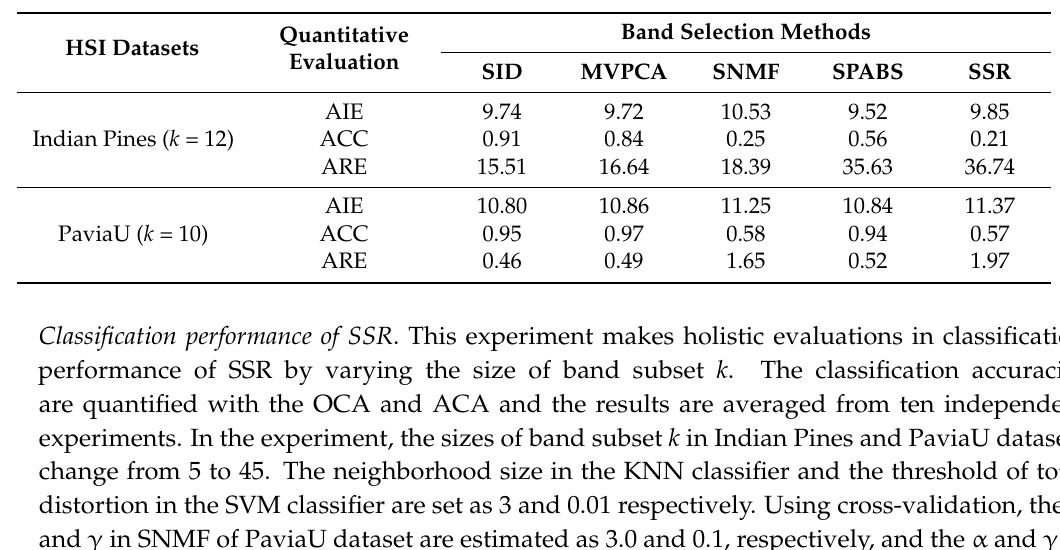
Table 3. Contrast in quantitative evaluation of band subsets from all five methods on both datasets. Quantitative HSI Datasets Evaluation